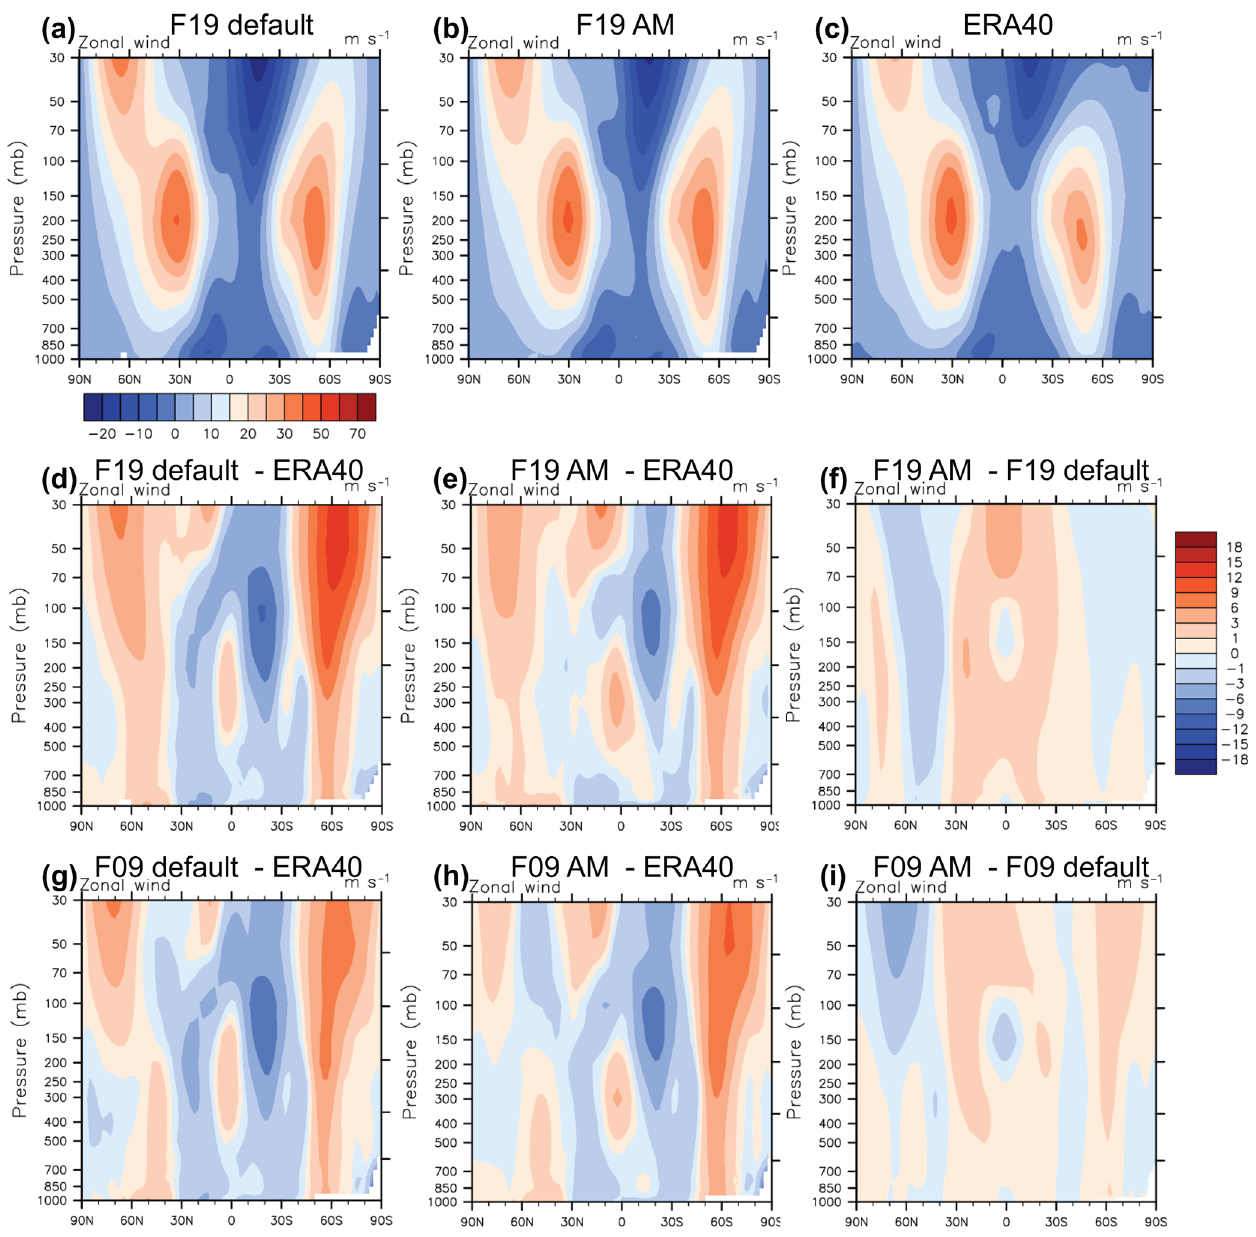
Figure 10. Impact of the AM correction and fixer in F2000 simulations. Latitude–pressure maps of zonal-mean zonal-wind climatologies for boreal winter (DJF). Panels (a) , (b) , and (c) show total fields for the CAM–FV f19 control simulation: (a) for the f19 simulation with both the AM fixer and AM correction (b) , as well as for the ERA40 reanalysis (Uppala et al., 2005). The colour scale is at the bottom of (a) . Panels (d) and (e) show the differences of each of the two f19 integrations and ERA40, and (f) shows the differences between the two f19 simulations. The colour scale is on the right of (f) . Panels (g) , (h) , and (i) are analogous to (d) , (e) , and (f) , respectively, but for CAM–FV simulations at 0.9 ◦ × 1.25 ◦ resolution. These plots were produced with the AMWG diagnostics package developed by the Atmospheric Model Working Group of the University Corporation for Atmospheric Research and the National Center for Atmospheric